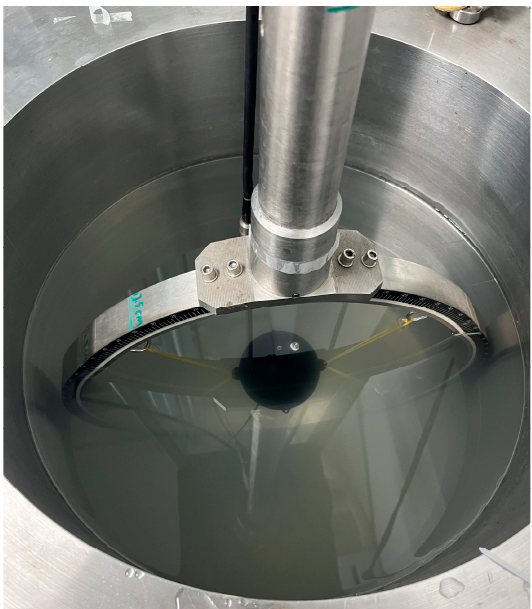
Figure 10. The practicality picture of the sensor in the standing wave tube. The experimental setup for measuring the phase sensitivity of the sensor is shown in Figure 11. According to Equation (24), we put the vector sensor and the standard hydrophone (with the sensitivity of − 190.8 dB re rad/ µ Pa) at the same depth d = 12.5 cm. A sinusoidal voltage generated by an arbitrary signal generator and amplified by a power amplifier is utilized to drive the shaker at the bottom of the standing wave tube, generating an acoustic signal for the sensor. The experimental results without castor oil in the sphere are shown in the blue curve of Figure 12a. The measured phase sensitivity is approximately − 190.6 dB (0 dB = 1 rad/ µ Pa) at 20 Hz. However, there is a resonance peak at 100 Hz, which is 26 Hz lower than the unpackaged. This may be attributed to the sound–structure coupling effect. When the sphere is excited, the aluminum support vibrates, generating a sound wave that acts on the cantilever. The cantilever amplifies or attenuates the sound wave, which subsequently reacts to the support. Consequently, the inherent mechanical vibration coupling of the support affects the DFB fiber laser, resulting in a low resonance frequency for the packaged sensor compared to the unpackaged